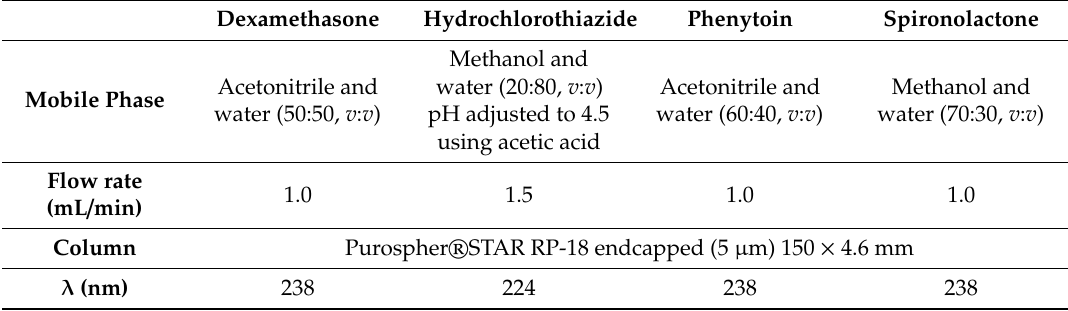
Table 1. Characteristics of the di ff erent analytical methods developed to perform